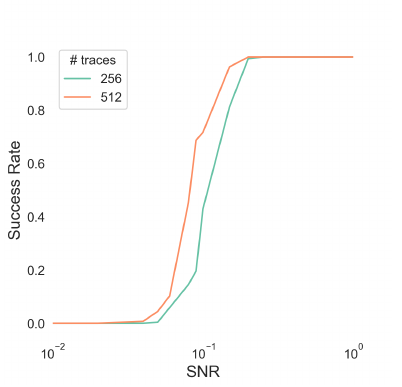
Figure 17: Success Rate of the attack with 256 traces (best case) or 512 traces (any